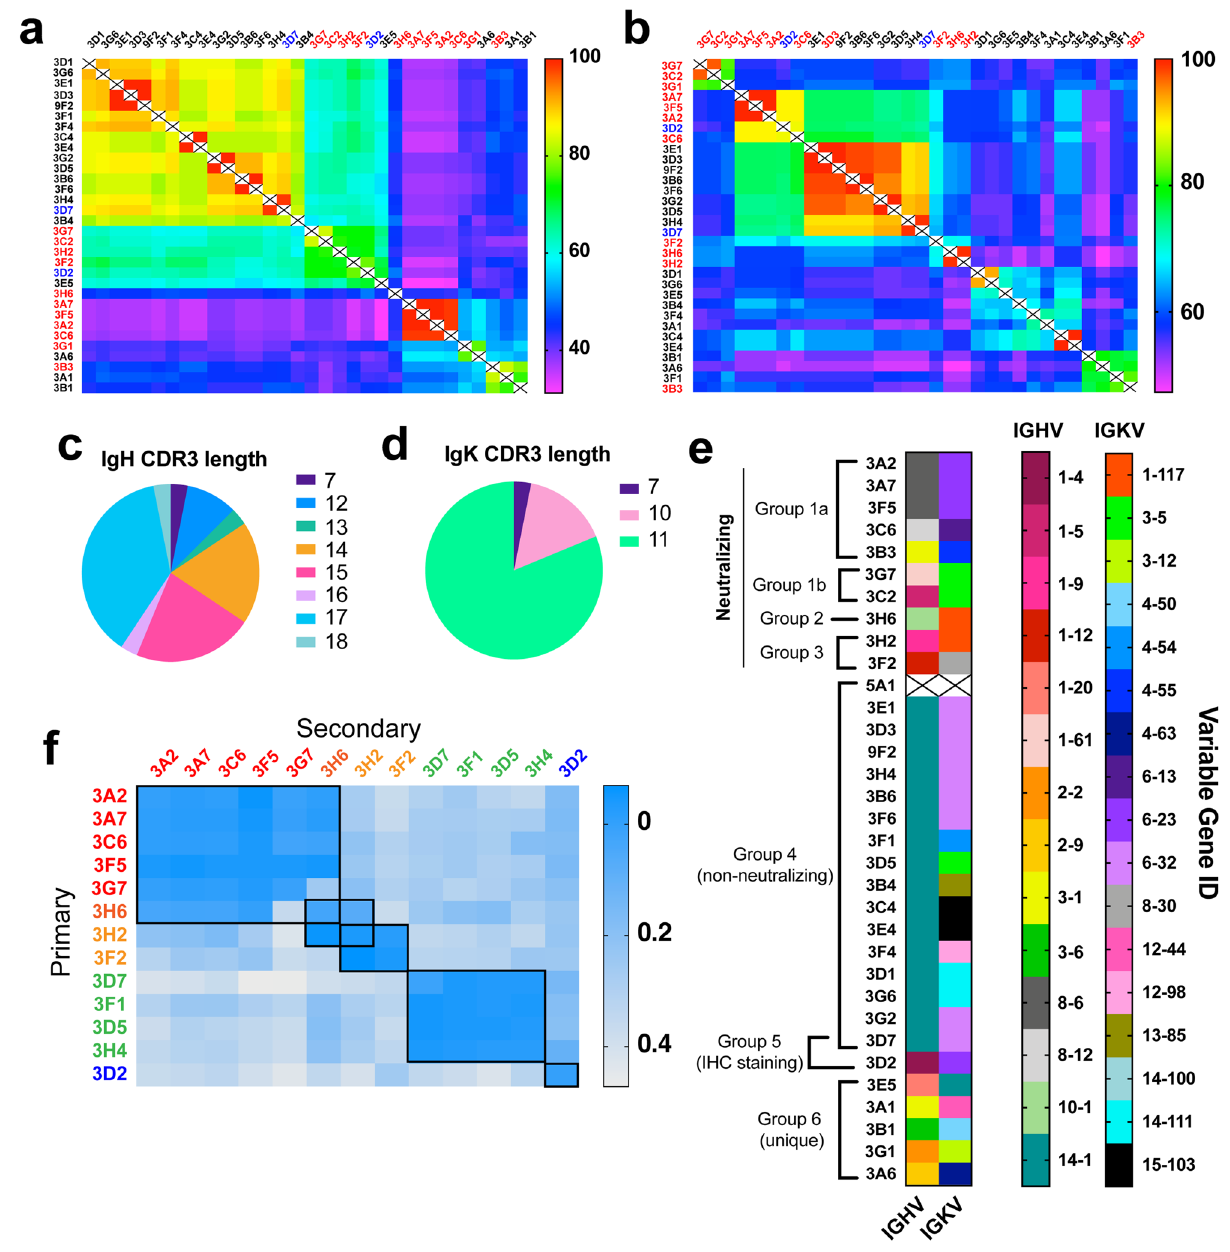
Figure 3. SARS-CoV-2 mAb sequences and epitope binning. ( a , b ) Overall similarity of ( a ) heavy chain and ( b ) light chain anti-SARS-CoV-2 antibody sequences, scored by percent of the total number of identical amino acids at each position. Antibody sequences were analyzed via MiXCR software and sequence alignment performed by Geneious. Neutralizing (red) and IHC staining mAbs (blue) determined via functional assays (Fig. 4) ( c , d ) Distribution of CDR3 amino acid length in heavy ( c ) and light ( d ) chains of 32 SARS-COV-2 mAbs. ( e ) IGHV and IGKV genes identified for mAbs from sequences in panels ( a ) and ( b ) . mAb 5A1 was not sequenced. Antibody grouping includes sequence, epitope, and function-level characteristics. ( f ) Representative assessment of competitive mAb binding to recombinant ectodomain immobilized to streptavidin-coated BLI sensor chips via Strep-tag sequence. Binding to the “primary” antibody was validated by BLI, followed by washing and exposure to the secondary antibody to generate the binding signal of spike protein to the truncated ACE2 receptor. Heat-inactivated virions obtained from ATCC were recognized by ELISA by only 3H2 (Supplementary Fig. S5c) among the mAbs described here. Recognition of gamma-irradiated SARS-CoV-2 USA/WA1/2020 virions was also not uniform among mAbs having roughly equal avidities for the recombinant spike ectodomain protein, as illustrated by ELISA analysis of 15 antibodies in Fig. 4g. Representative dose–response analysis showed that, while both 3H2 and 3A2 were equivalently potent in in vitro neutralization, the former mAb generated significantly larger ELISA signals at